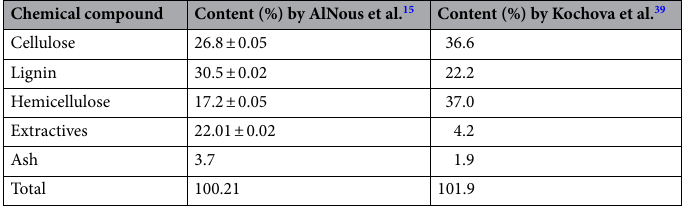
Table 1. Chemical composition of